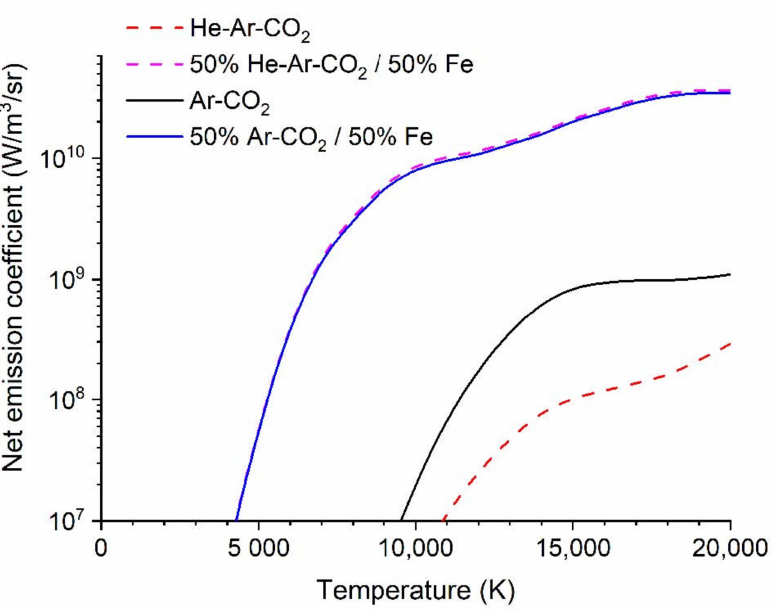
Figure 14. Net emission coefficient for the ternary and binary blends and for 50 mol% mixtures of each blend with metal vapor as a function of temperature